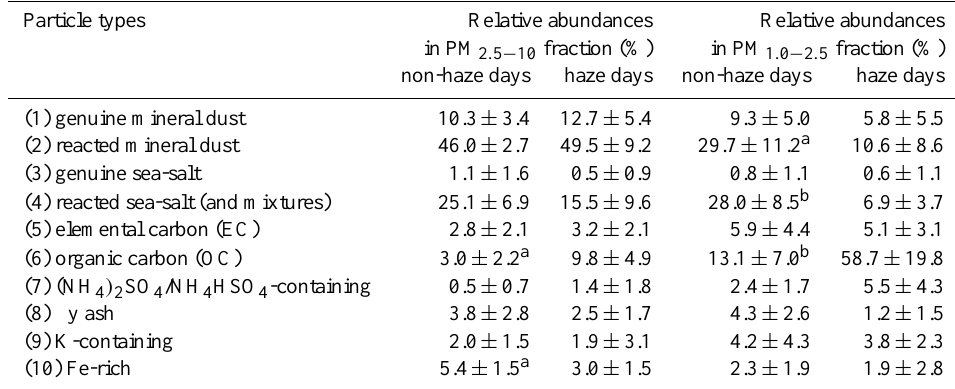
Table 3. Relative abundances of major particle types on haze vs. non-haze